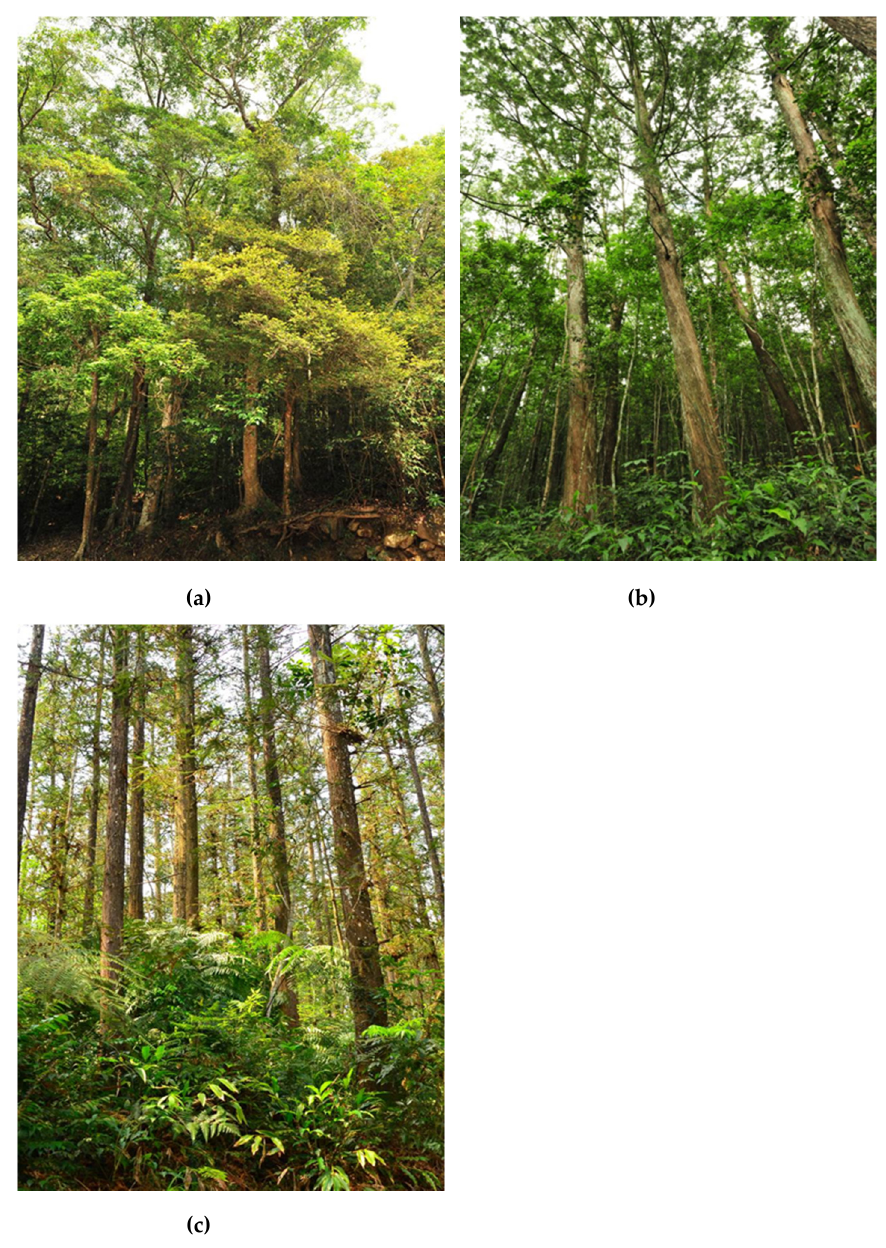
Figure 1. Photographs of ( a ) natural broadleaf (BROAD ‐ Nat), ( b ) 80 ‐ year ‐ old coniferous (CONIF ‐ 80), and ( c ) 40 ‐ year ‐ old coniferous (CONIF ‐ 40) forests at the study